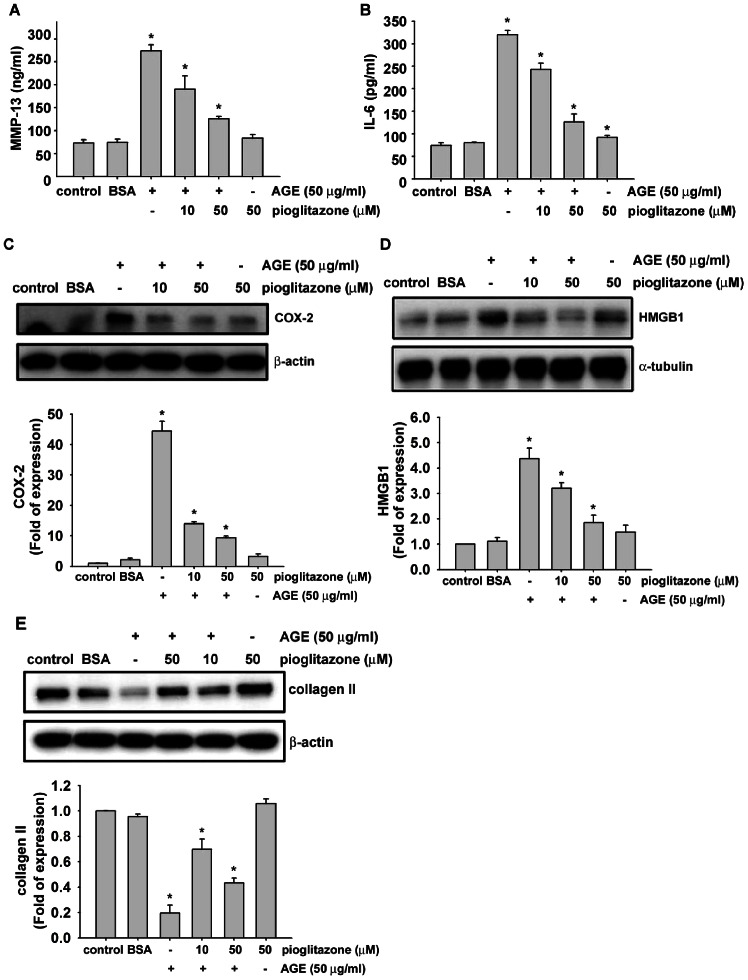
Effects of pioglitazone on inflammatory signalings in human OA chondrocytes.Human OA chondrocytes (1×106/ml) were pretreated with pioglitazone (10 and 50 µg/ml) for 1 hour followed by stimulating with AGEs (50 µg/ml) for 24 hours. Productions of MMP-13 (A) and IL-6 (B) were quantified by specific ELISA kits. Protein expressions of COX-2, HMGB1, and collagen II were determined by Western blotting (C). Densitometric analysis for COX-2, HMGB1, and collagen II levels corrected to β-actin is shown. All data are presented as mean ± SEM for three independent experiments. *: P<0.05 versus control. #: P<0.05 versus AGEs alone.